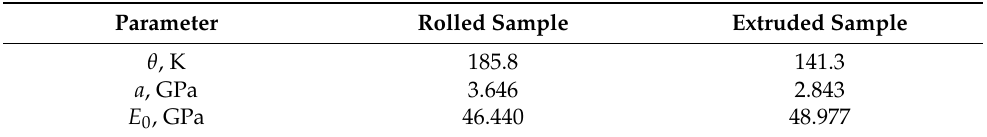
Table 1. Parameters of approximation of the dynamic Young’s modulus temperature dependences by Equation (8) for rolled and extruded Mg